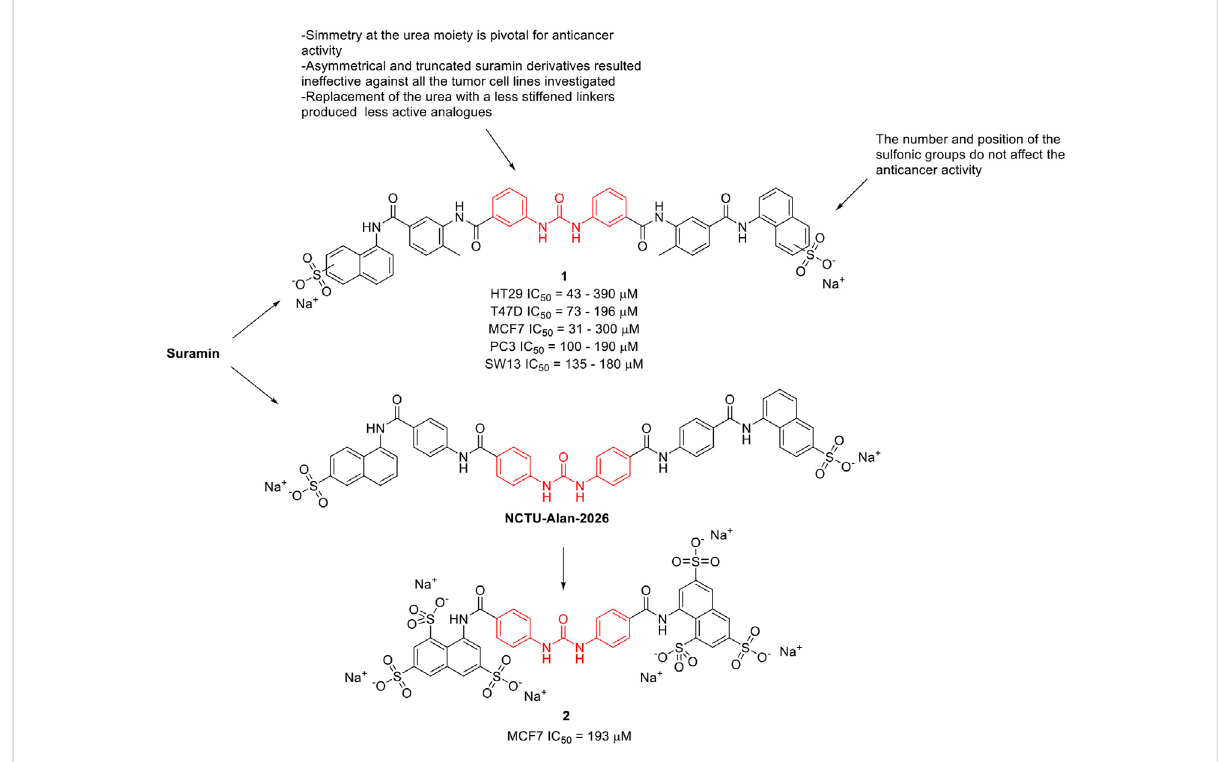
FIGURE 2 Chemical structures and SAR highlights of the suramin ’ s derivatives with proved anticancer